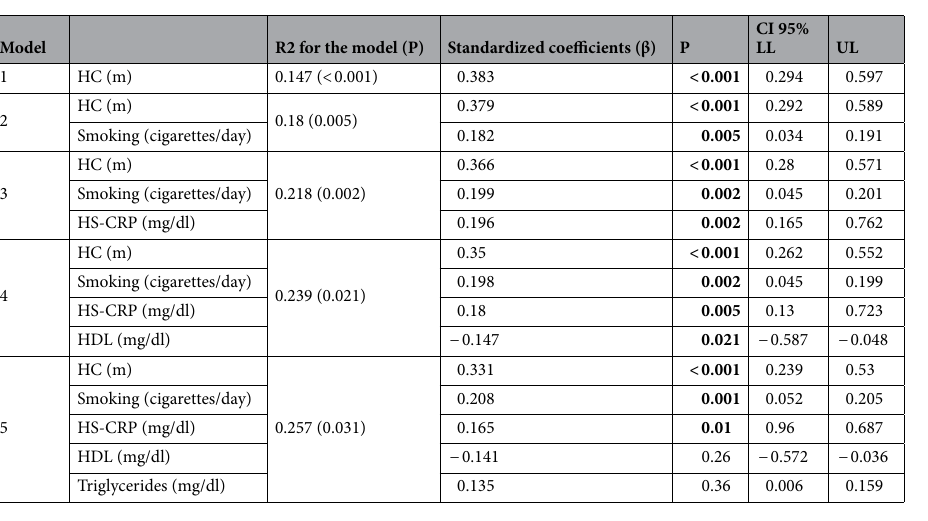
Table 5. Forward linear regression between obesity parameters and socio-demographic and health variables, and the number of severe stenosed coronary arteries (≥ 60%) ( N = 220). The last model explained 25.7% of the variation of frailty score (P = 0.031). Significant values are in bold.